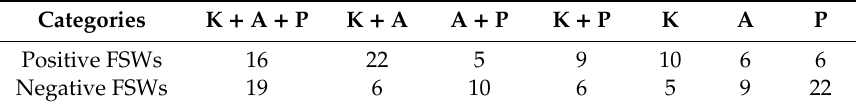
Table 2. Positive / negative distributions of